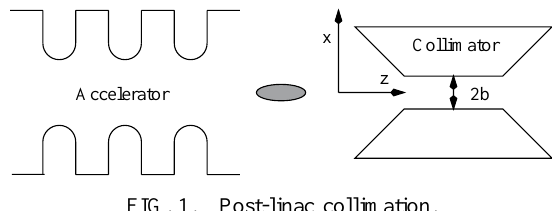
FIG. 1. Post-linac collimation. FIG. 2. Electron bunch passing through a smooth